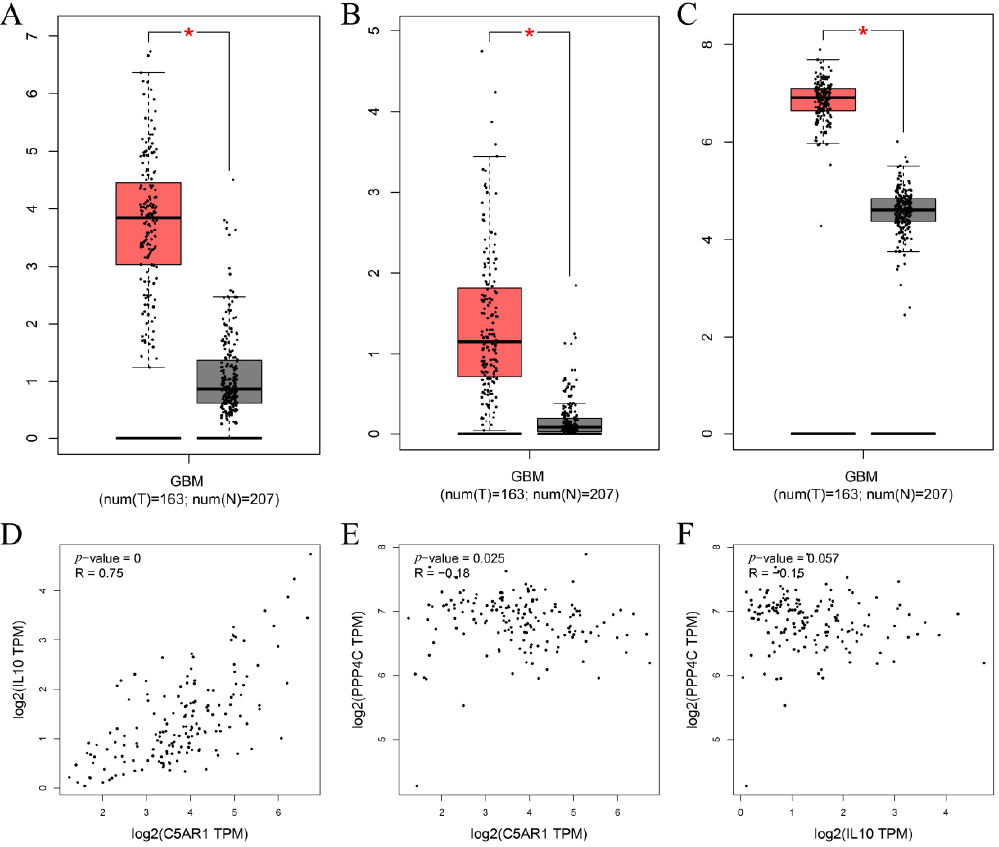
Figure 6. Expression of ( A ) C5AR1, ( B ) IL10, and ( C ) PPP4C in GBM was markedly higher than in normal tissues from TCGA-GBM database (* p < 0.05). Relationship analysis of three key genes: ( D ) C5AR1 and IL-10, ( E ) C5AR1 and PPP4C, and ( F ) PPP4C and